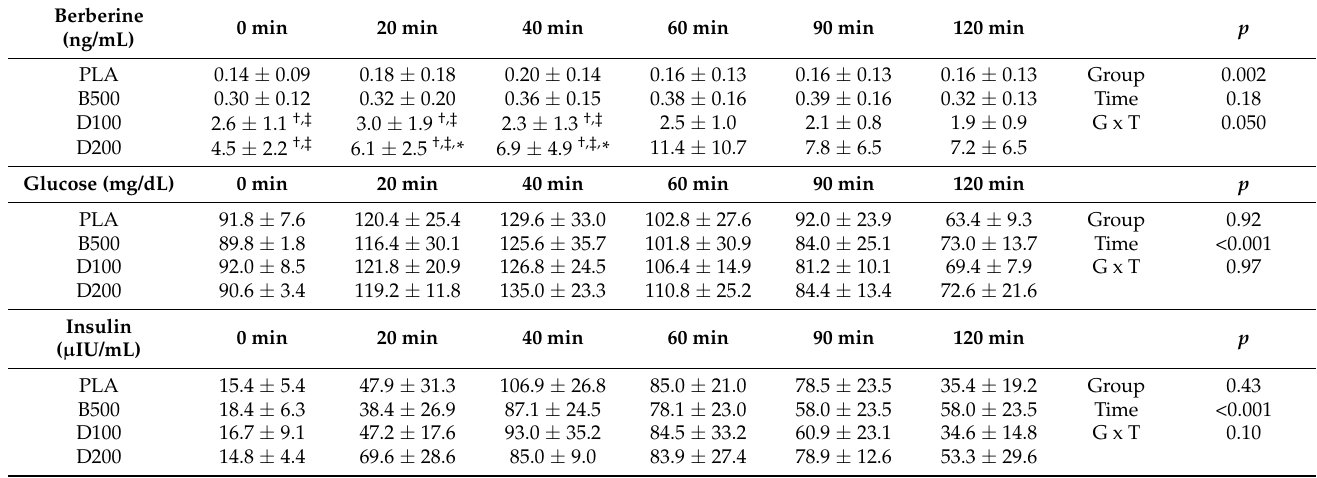
Table 4. Berberine (ng/mL), glucose (mg/dL), and insulin ( µ IU/mL) data.